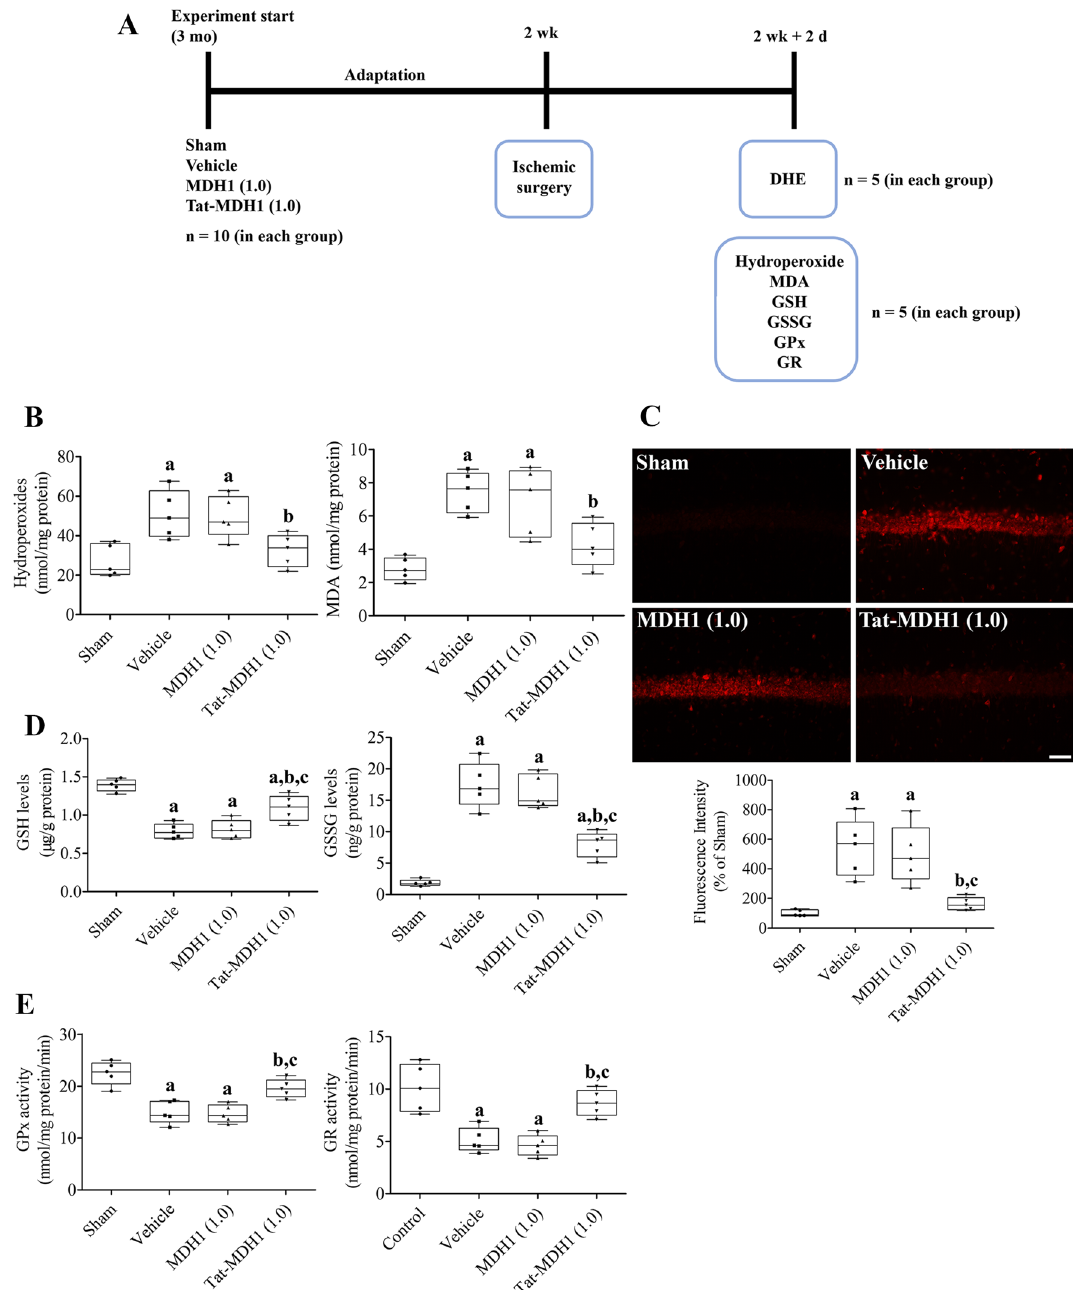
Figure 5. In vivo effects of Tat-MDH1 on oxidative stress and GSH system in hippocampus 2 days after ischemia. ( A ) Schematic drawing of the experimental protocol used for measuring oxidative markers and reduced glutathione (GSH) systems. ( B ) Oxidative stress was assessed by measurements of hydroperoxides and malondialdehyde (MDA) in the hippocampus. ( C ) Oxidative damage is visualized by dihydroethidium (DHE) fluorescence in the hippocampus. ( D and E ) Levels of reduced GSH and oxidized glutathione (GSSG) as well as glutathione peroxidase (GPx) and glutathione reductase (GR) activities were determined in the hippocampus 2 d after ischemia. Data were analyzed using one-way analysis of variance followed by Tukey’s multiple comparison post hoc test ( a p < 0.05, significantly different from the sham-operated group; b p < 0.05, significantly different from the vehicle-treated group; c p < 0.05, significantly different from the 1 mg/kg MDH1-treated group [MDH1 (1.0)]). Data are shown as mean + standard